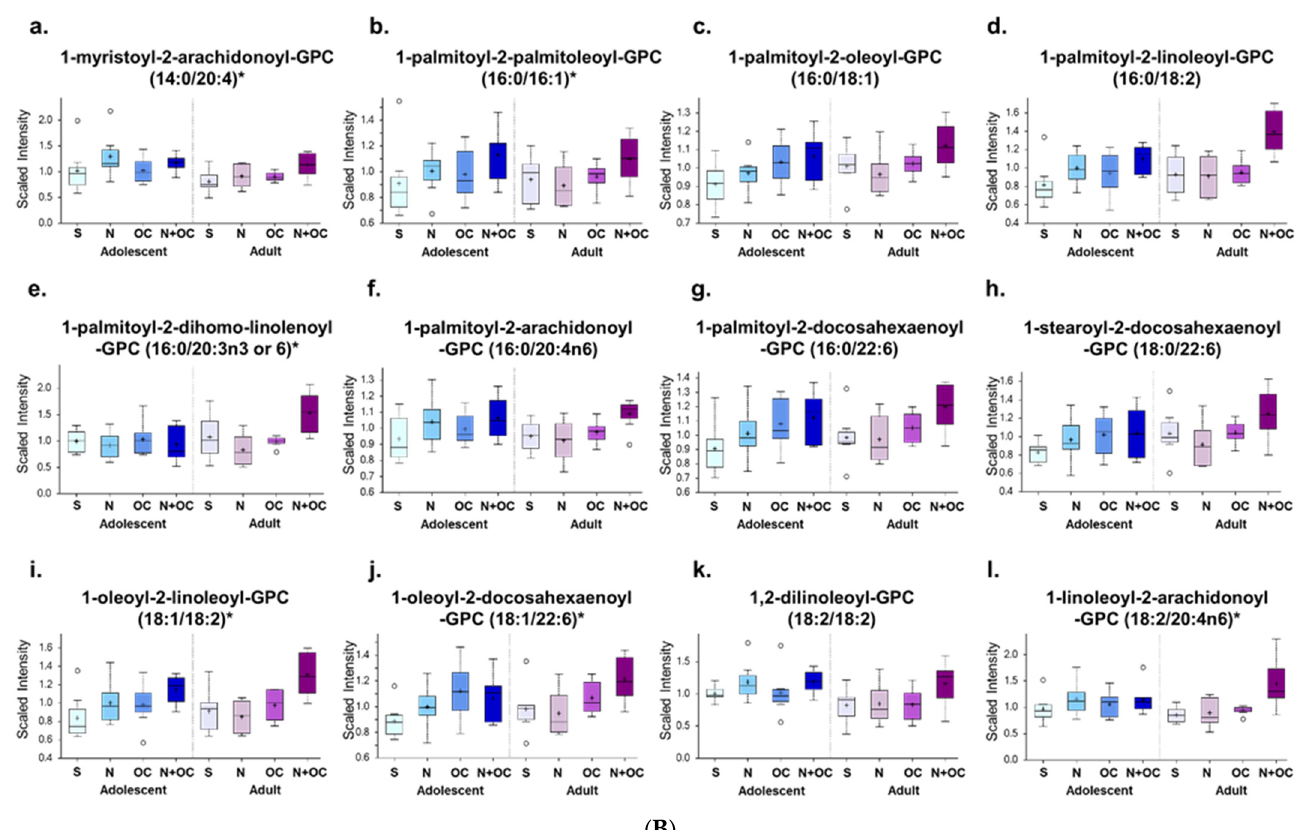
Figure 6. N + OC alters PC metabolites in the cortex of adolescent female rats. ( A ) The biosynthesis (Kennedy pathway), remodeling, and degradation that takes place in relation to PC metabolism. ( B ) Box plots showing that N + OC alters PC metabolites. ( a – l ) Box plots show significant alterations in 1-myristoyl-2-arachidonoyl-GPC (14:0/20:4)*, 1-palmitoyl-2-palmitoleoyl-GPC (16:0/16:1)*, 1- palmitoyl-2-oleoyl-GPC (16:0/18:1), 1-palmitoyl-2-linoleoyl-GPC (16:0/18:2),